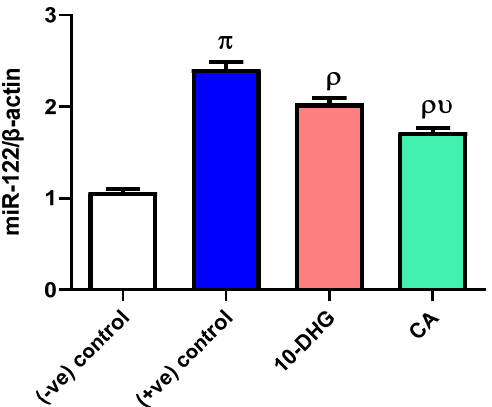
Figure 1. Effects of caffeic acid and 10-dehydrogengerdione treatment on miR-122 expression. (-ve)